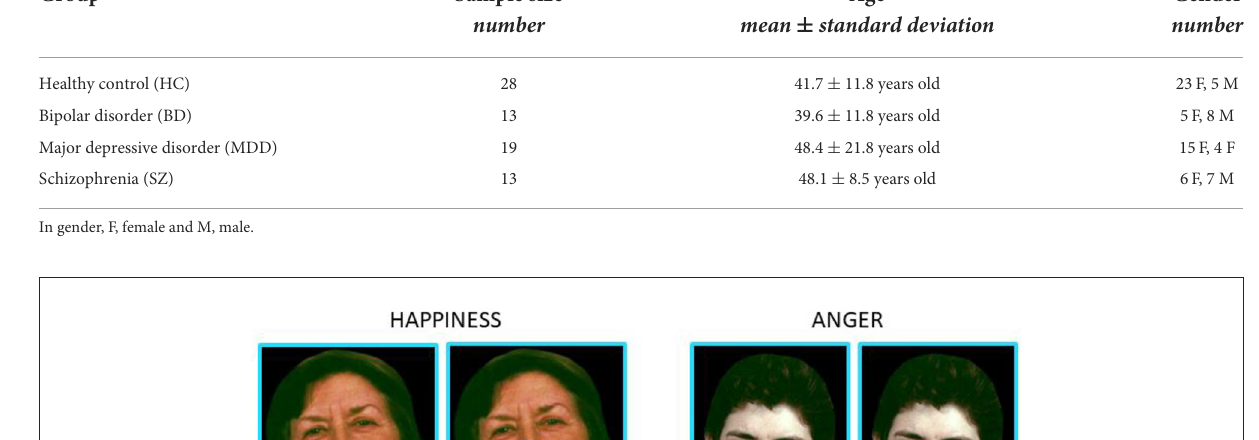
presented in randomized order, including four repetitions of four facial emotions (happiness, sadness, fear, anger) with